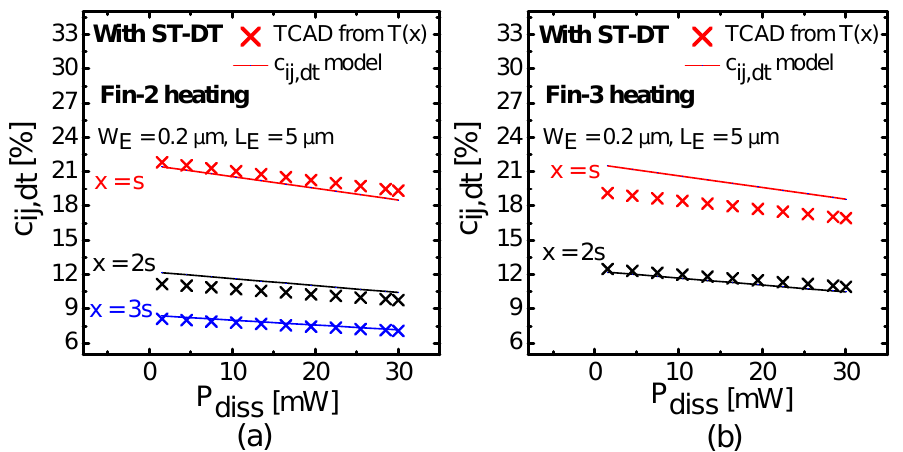
Figure 7. P diss —dependent c ij , dt at different sensing fingers when ( a ) 2nd and ( b ) 3rd fingers are heating individually in a five-finger device with A E = 0.2 × 5 µ m 2